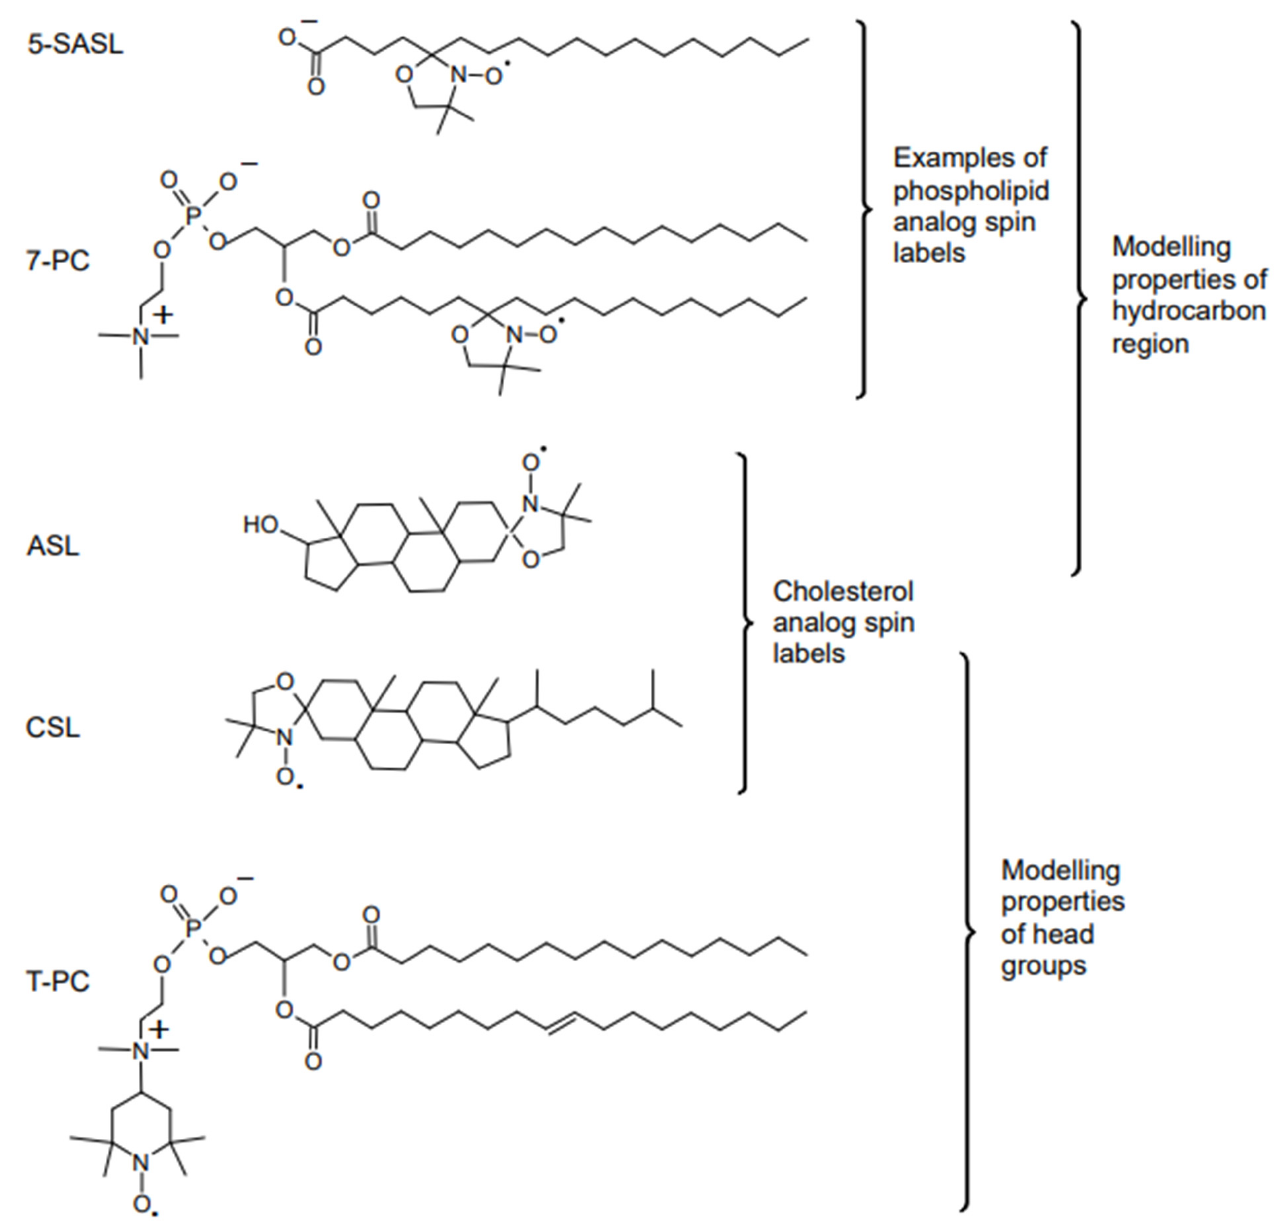
Figure 2. Chemical structures of selected lipid spin labels used for membrane studies. The phospholipid analogs 7-doxylstearic acid spin label (5-SASL) and 1-palmitoyl-2-(7-doxylstearoyl)phosphatidylcholine (7-PC) models properties of the membrane hydrocarbon region, cholesterol analogues cholestane spin label (CSL), and androstane spin label (ASL) model the behavior of Chol molecules in the lipid bilayer, and the phospholipid analog tempocholine-1-palmitoyl-2-oleoylphosphatidic acid ester (T-PC) models properties of the head groups region.